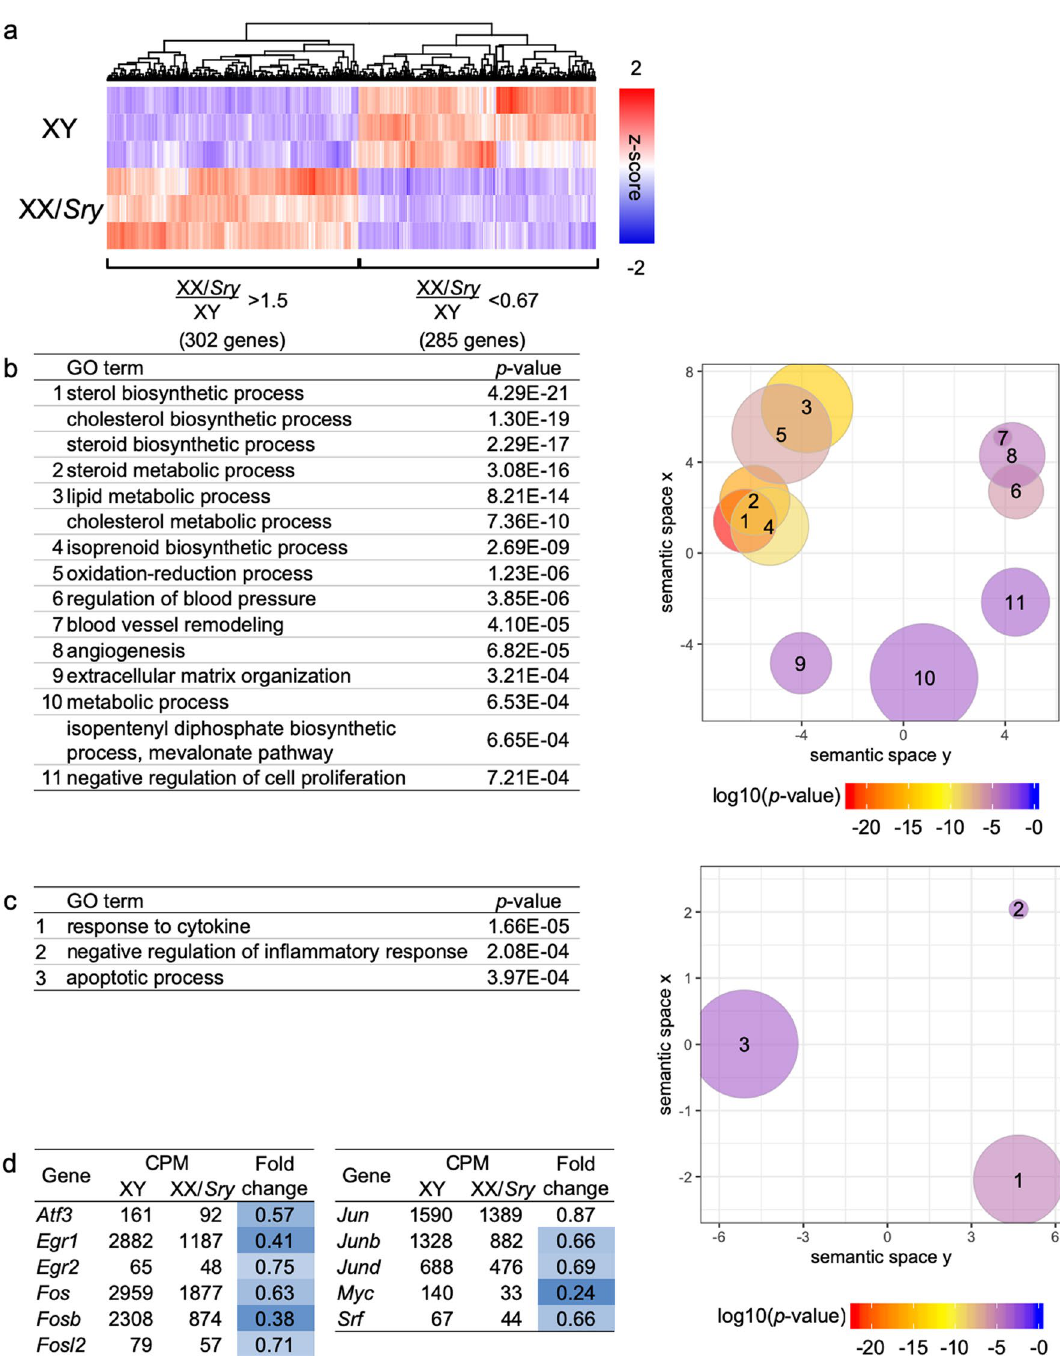
Figure 2. Genes differentially expressed in XY and XX/ Sry ALCs. ( a ) Heatmap of differentially expressed genes in XY and XX/ Sry ALCs, based on a comparison of their transcriptomes. The expression levels of 302 genes were at least 1.5 times higher in XX/ Sry than XY ALCs, and those of 285 genes in XX/ Sry were at most two third of those in XY ALCs. ( b ) GO terms identified by GO pathway analyses of the 302 upregulated genes in XX/ Sry ALCs are indicated (left) and visualized in a two-dimensional plot using REVIGO (right). The top 15 GO terms ( p < 0.001) were plotted by REVIGO after four redundant terms had been excluded. The numbers in the plots correspond to the numbers of the GO terms shown in the left-hand column of the table. The plot colors indicate the p -values of the GO terms as per the table, and plot sizes indicate the specificity of the terms (plots for more specific terms are smaller). ( c ) GO terms identified by GO pathway analyses of the 285 genes downregulated in XX/ Sry ALCs are indicated and visualized as described above. The top three GO terms ( p < 0.001), which were used for the analysis, are listed in the table on the left and plotted in the panel on the right. ( d ) Expression of immediate early genes in XY and XX/ Sry ALCs. CPMs are means of biological triplicates for each cell type. Cells in the fold change column are shaded according to difference in expression: the greater the decrease, the deeper the blue shading. R software version 3.4.3 (https ://www.r-proje ct.org) was used to draw the plots in ( a – c